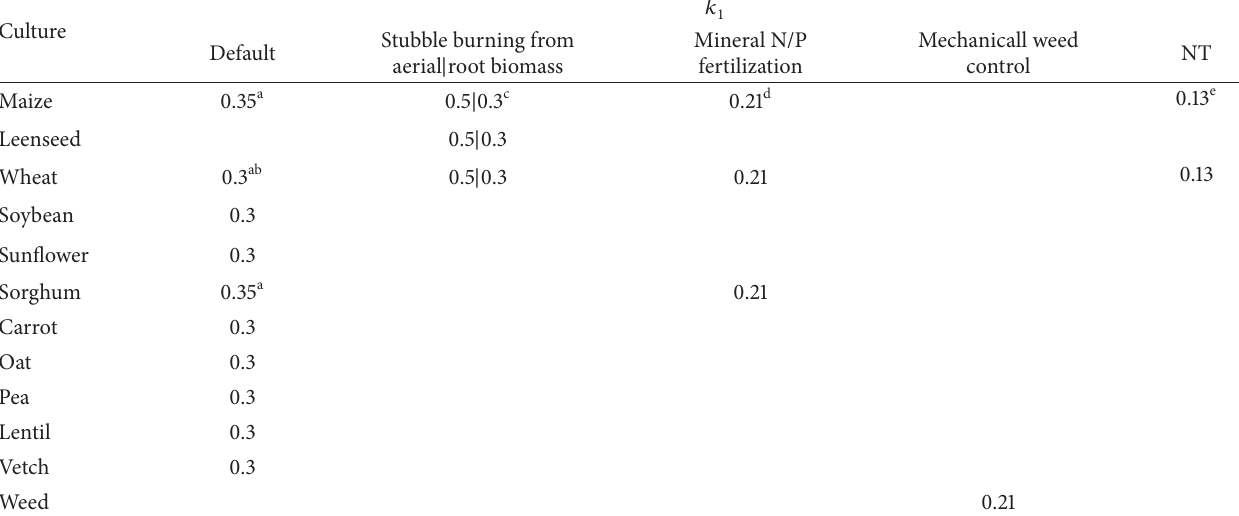
Table 3: Crop 𝑘 1 values used in the validation procedure as a function of the predominant soil residue